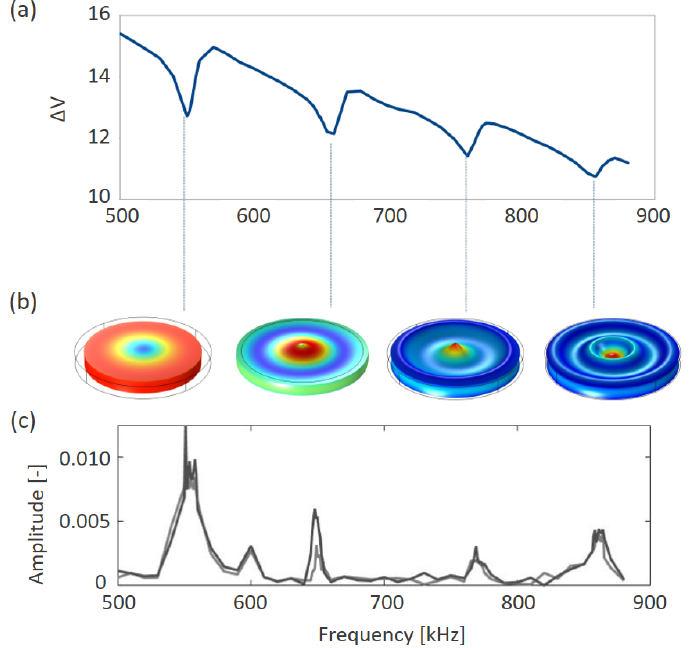
Figure 4. ( a ) Piezoelectric actuator signal: variation of potential versus frequency. ( b ) Radial modes of the piezoelectric disk. ( c ) Photodiode signal on